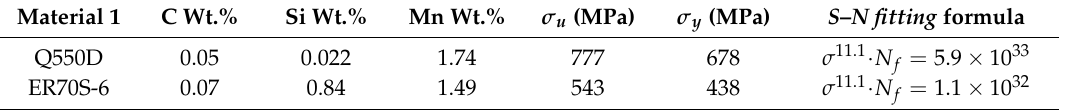
Table 1. Chemical composition and mechanical properties of the base metal and weld metal.